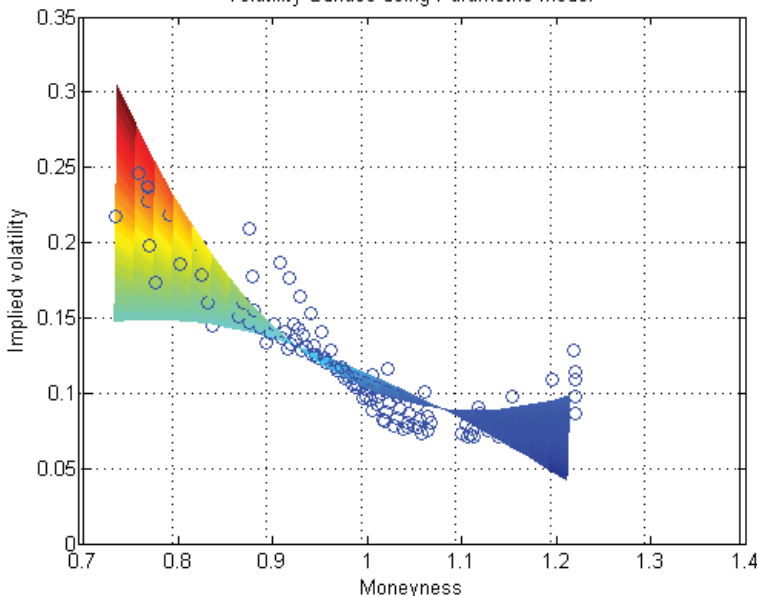
Fig. 5. Estimated implied volatility surface (2D) for model 2. The blue circles are the observed